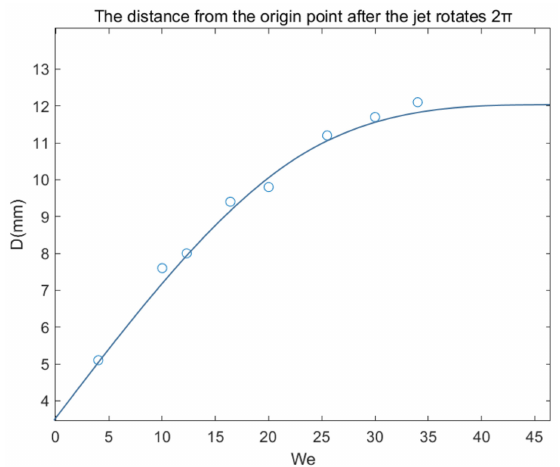
Figure 13. The distance from the center of the circle when the jet rotates ϕ = 2 π